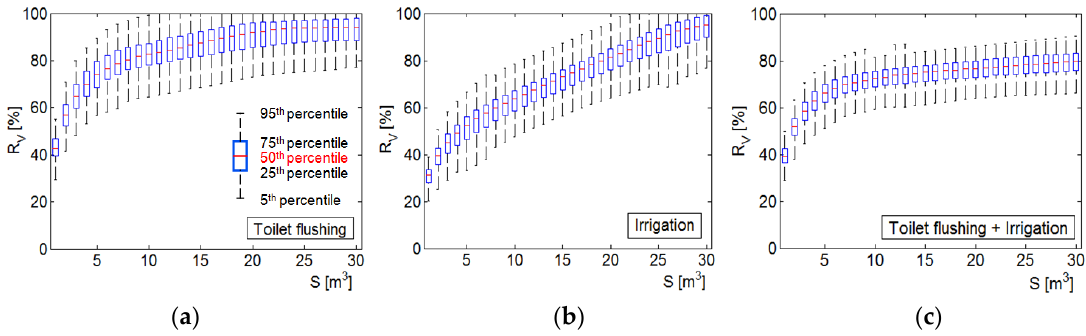
Figure 4. Box-whisker graphs of the daily reliability R V vs. tank capacity S for different rainwater uses. ( a ) toilet flushing use; ( b ) irrigation use; ( c ) toilet flushing and irrigation use;